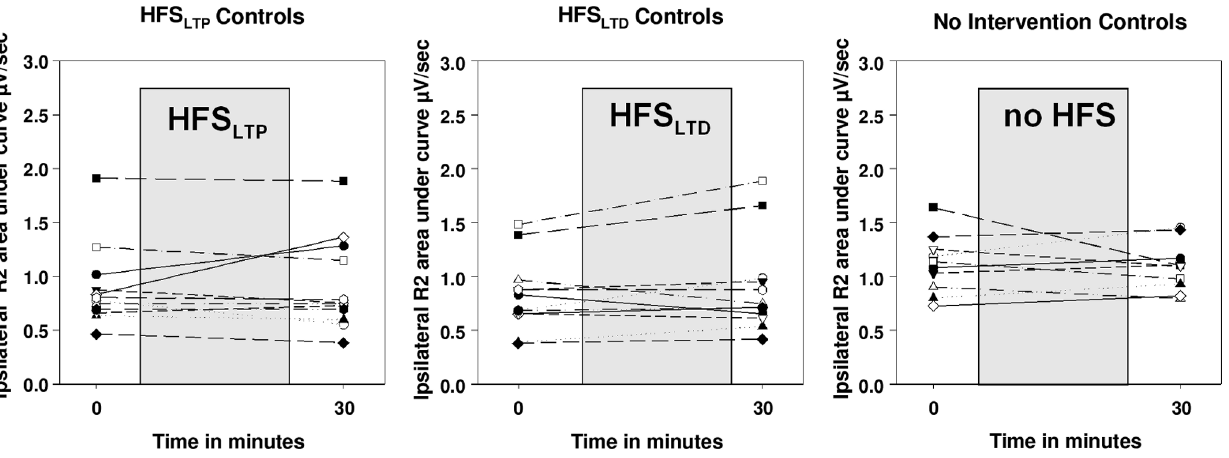
Figure 7. R2 response of each control person at baseline and after HFS LTP , HFS LTD , and HFS non-intervention . In analogy to Figure 6, individual results of each control subject before and immediately after HFS for the HFS LTP , HFS LTD and non-intervention protocol are presented.